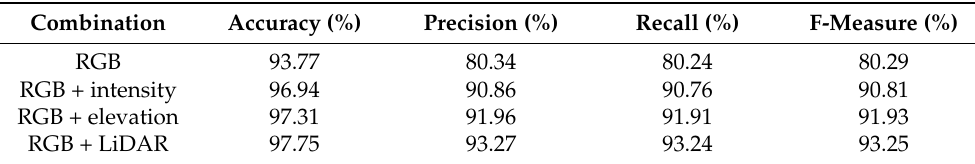
Table 4. Comparison of indicator parameters for the four combinations using DCNN.